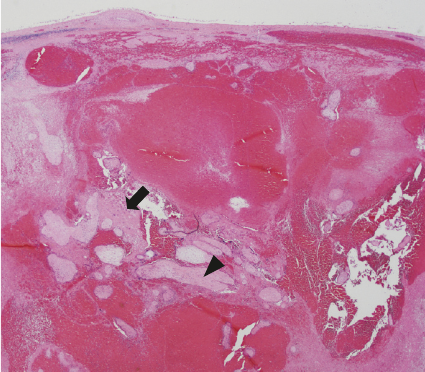
Figure 1: Necrotic myometrium (arrow) with degenerating chori- onic villi (arrowhead) transecting through the entire myometrial thickness to the serosal surface with extensive hemorrhage (H&E stain, 20x